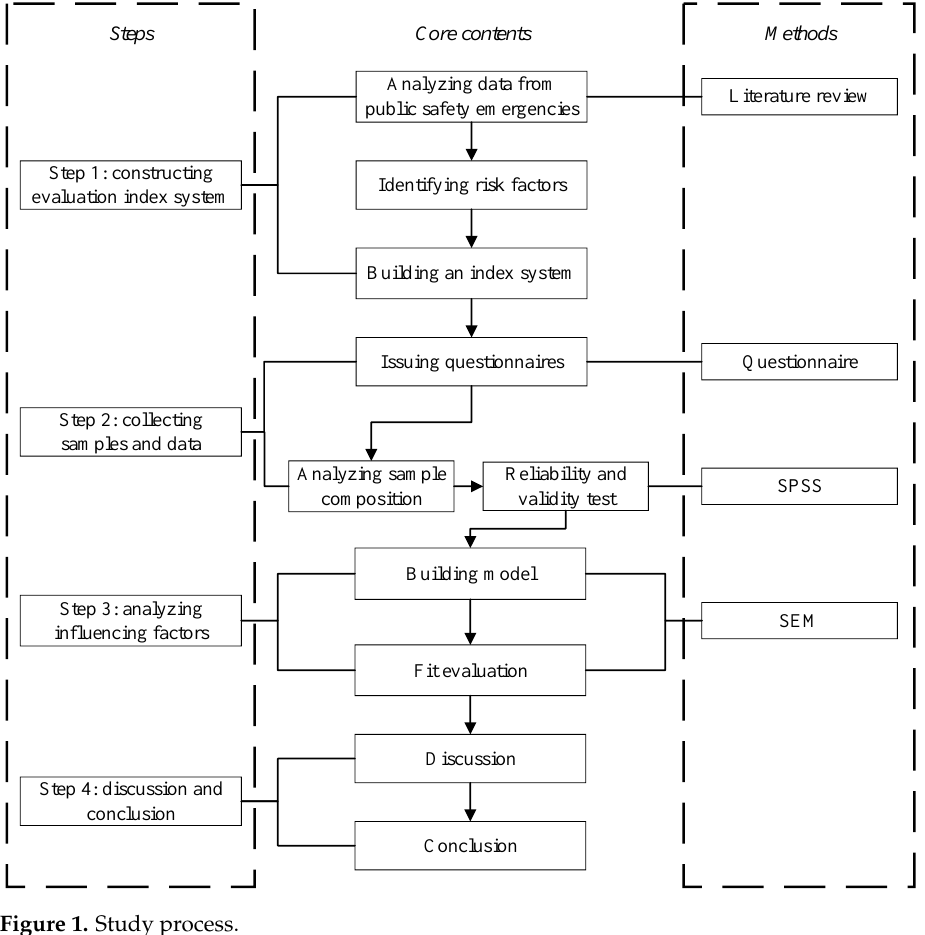
Figure 1. Study process.